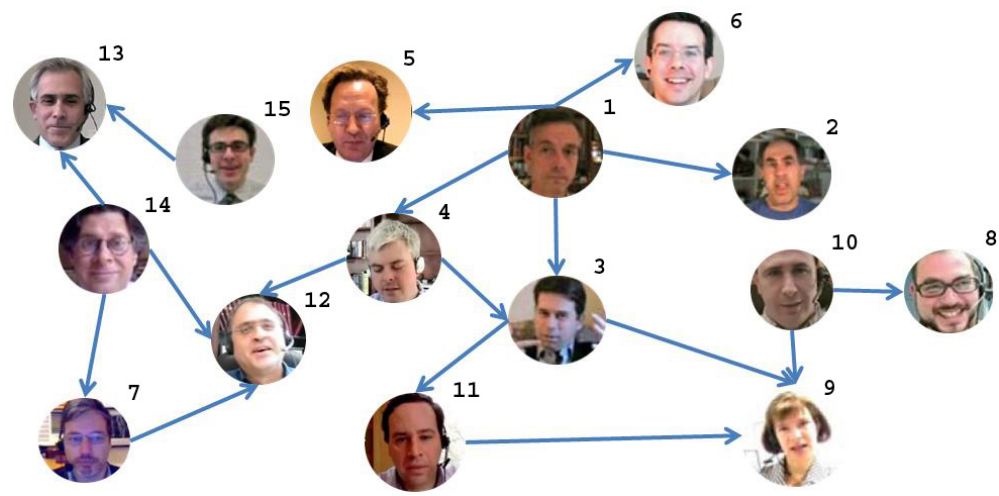
Figure 7. Social Network showing participant labels and influence